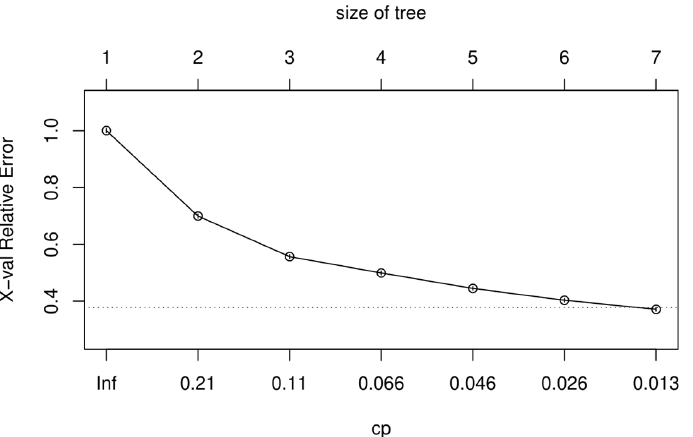
Figure 4. X-val relative error of the DT model as a function of the different sizes of tree and corre- sponding cp value.